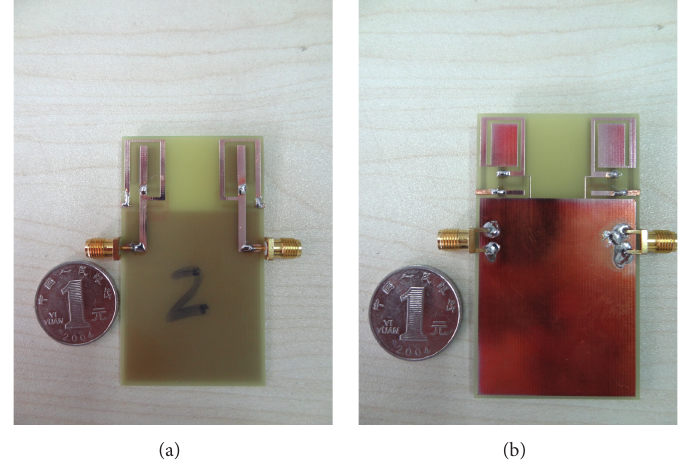
Figure 6: Prototype photograph of the proposed antenna: (a) top layer; (b) bottom layer.